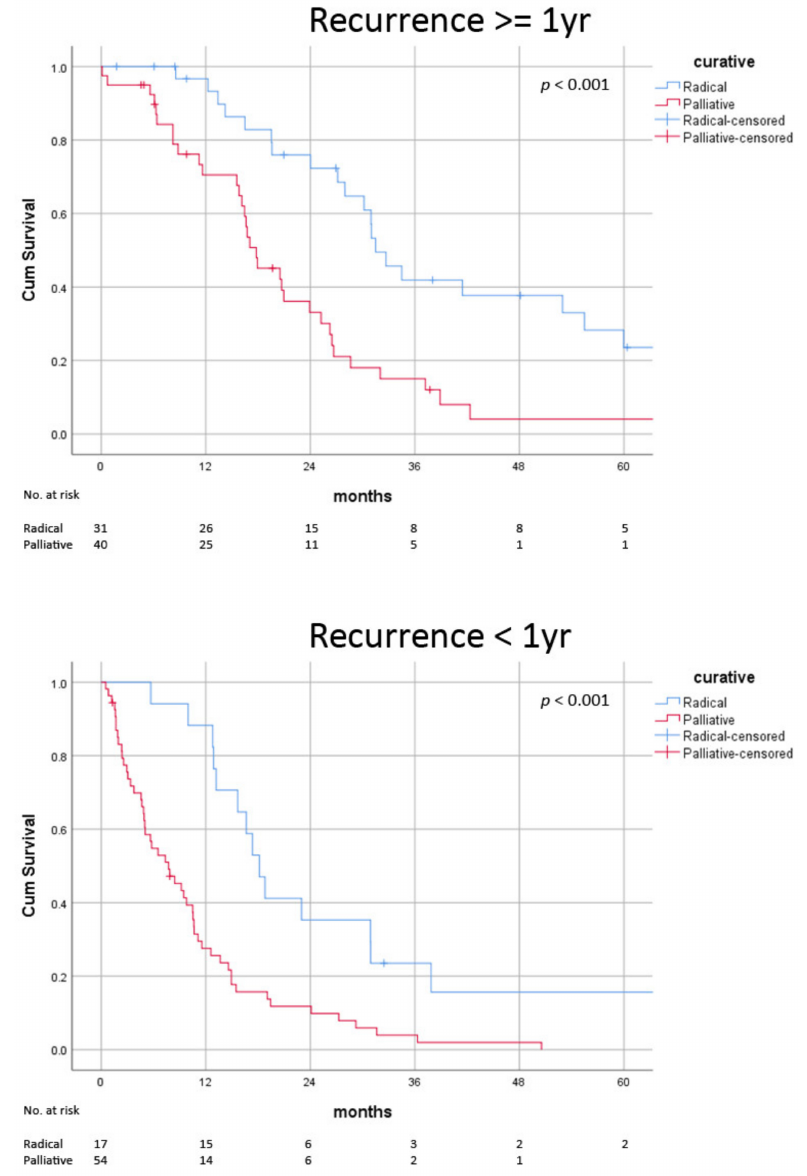
Figure 2. Post-recurrence survival of radical versus palliative treatment in late and early